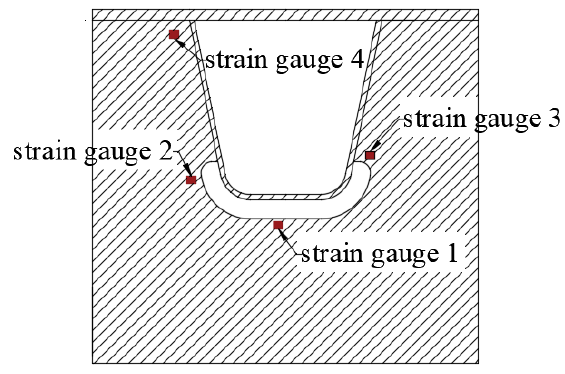
Figure 5. Finite element model of the bridge deck.